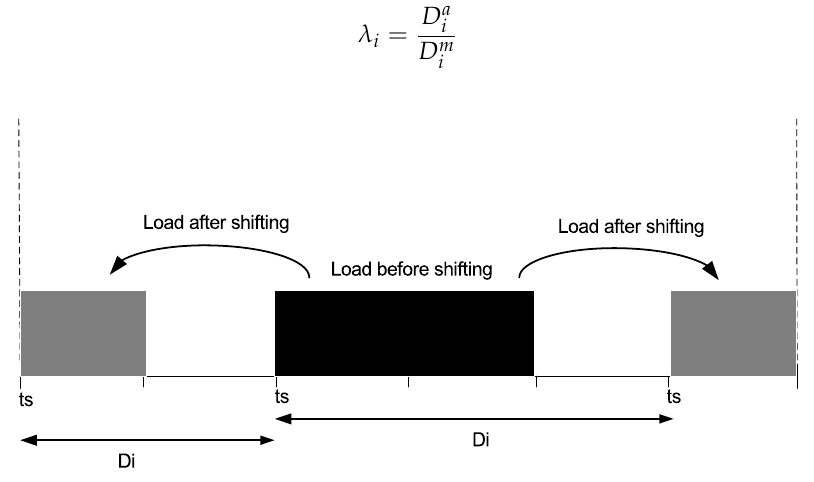
Figure 4. Appliance waiting